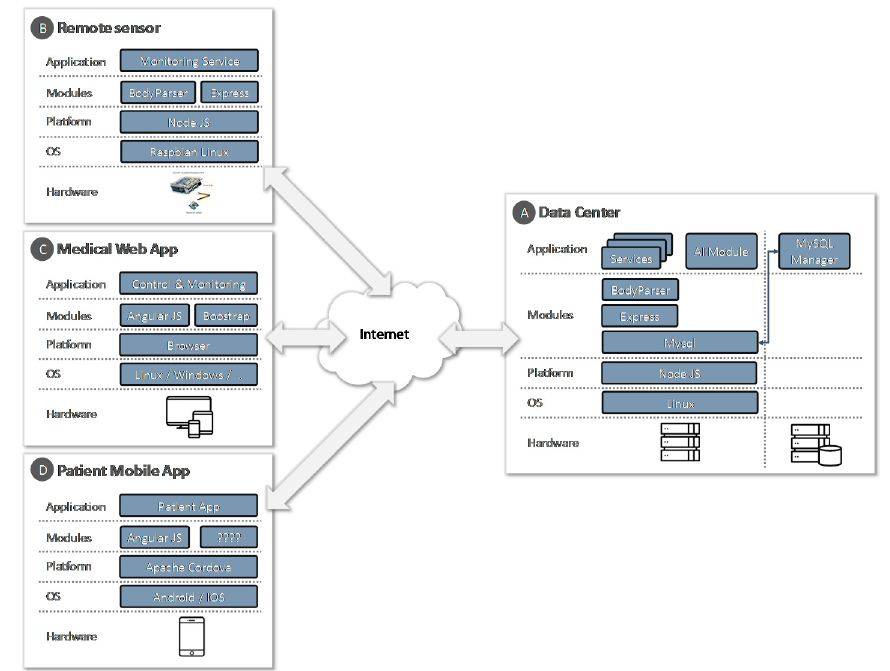
Figure 5. Technological architecture of system components.